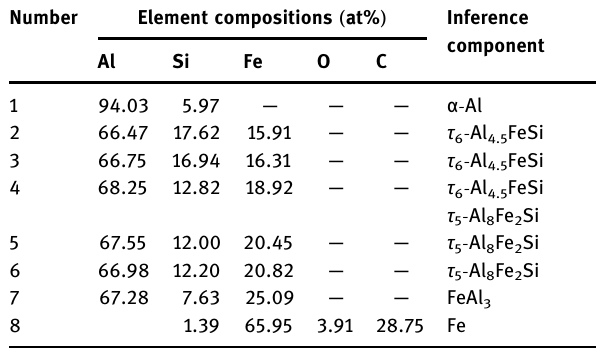
Table 1: Results of EDS analysis corresponding to the points indi